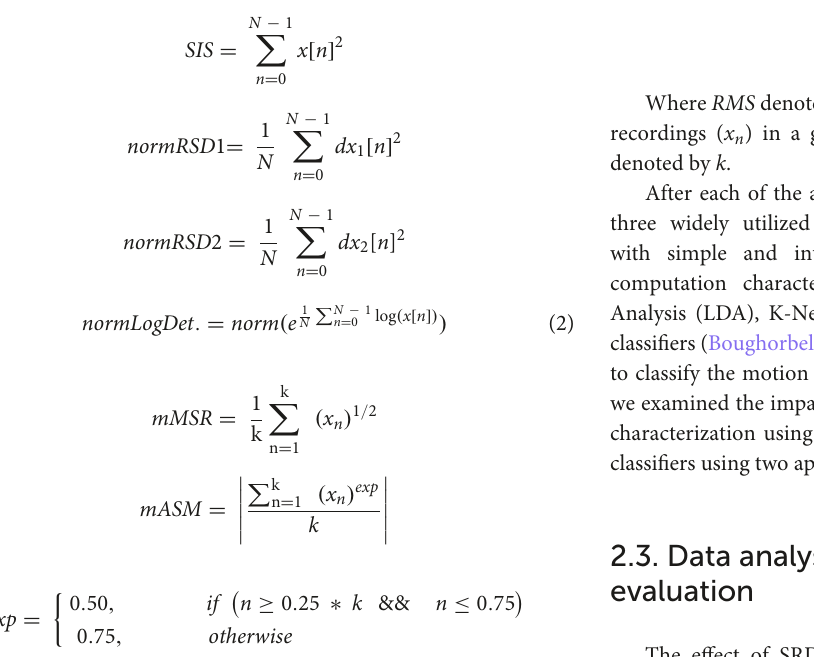
zero (baseline), and SSC denotes an alternative but complementary measure of the number of times the slope changes sign (Hudgins et al., 1993; Englehart and Hudgins, 2003). And an aggregation of these descriptors forms the TD4 feature set that was adopted in the subsequent section of the manuscript (Hudgins et al., 1993; Englehart and Hudgins, 2003). Meanwhile, the Thr. (with a value of 0.01) represent the threshold upon which the SCC value is